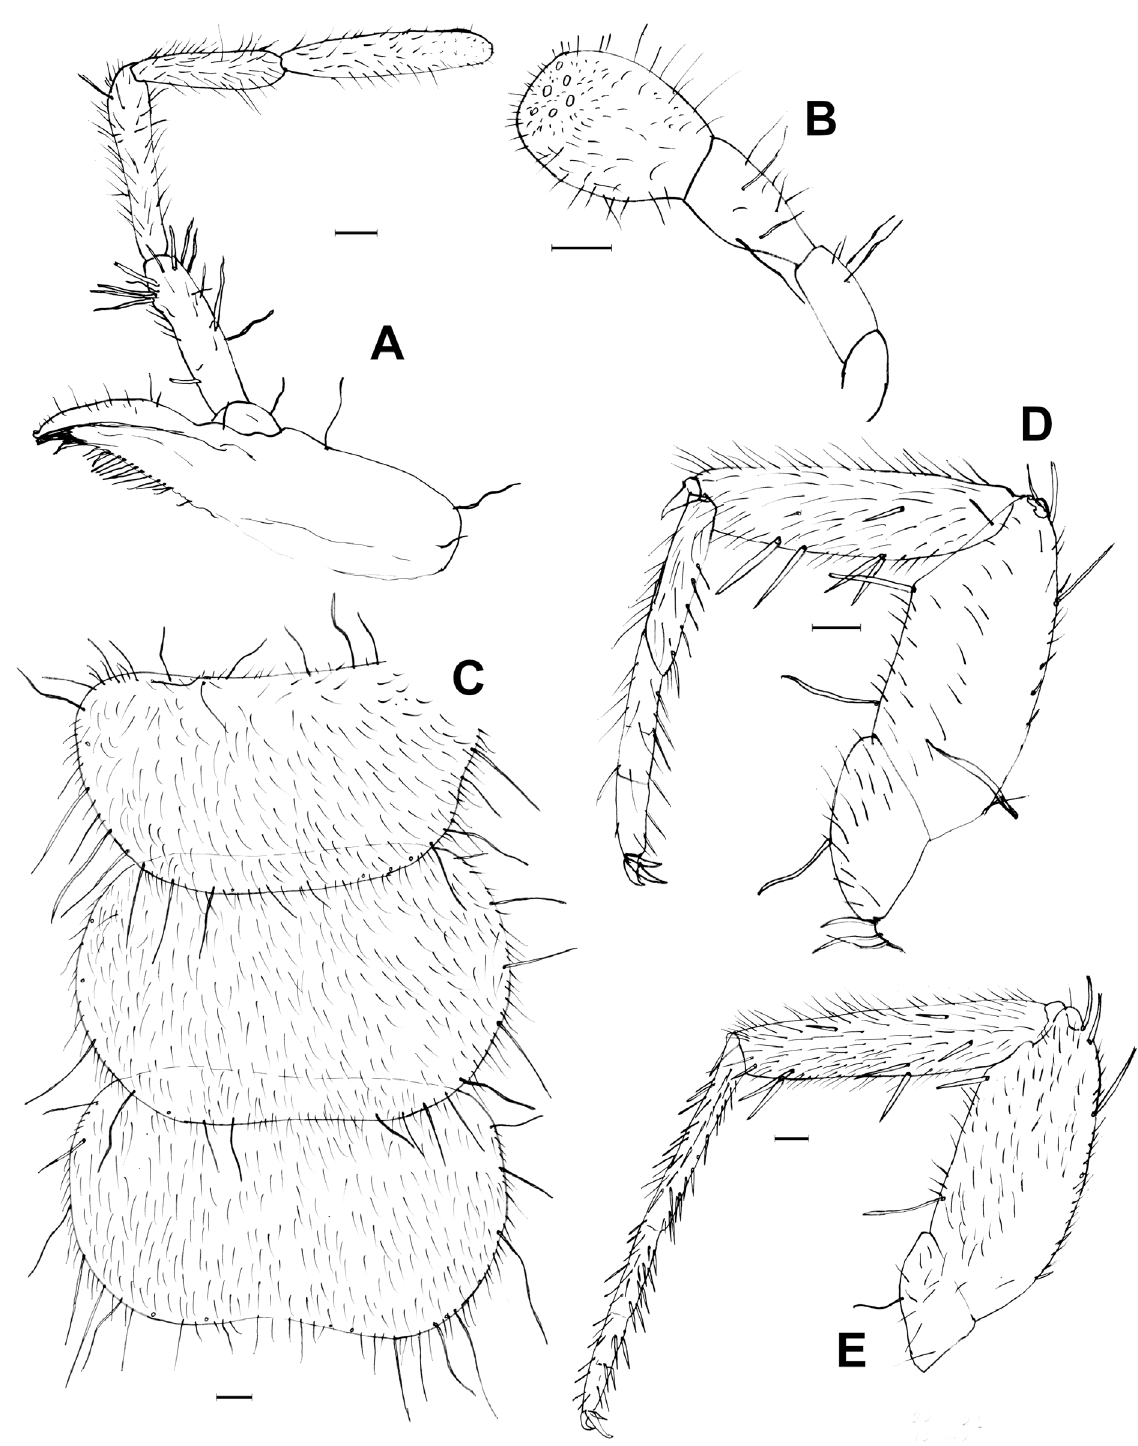
Fig. 7. Coletinia dextra Molero-Baltanás, Bach de Roca & Gaju-Ricart sp. nov. Holotype, ♂ (MNCN_ Ent 283557). A . Maxilla and maxillary palp. B . Labial palp. C . Thoracic nota. D . First leg, except coxa. E . Third leg, except coxa. Scale bars: A, C–E = 0.1 mm; B = 0.2